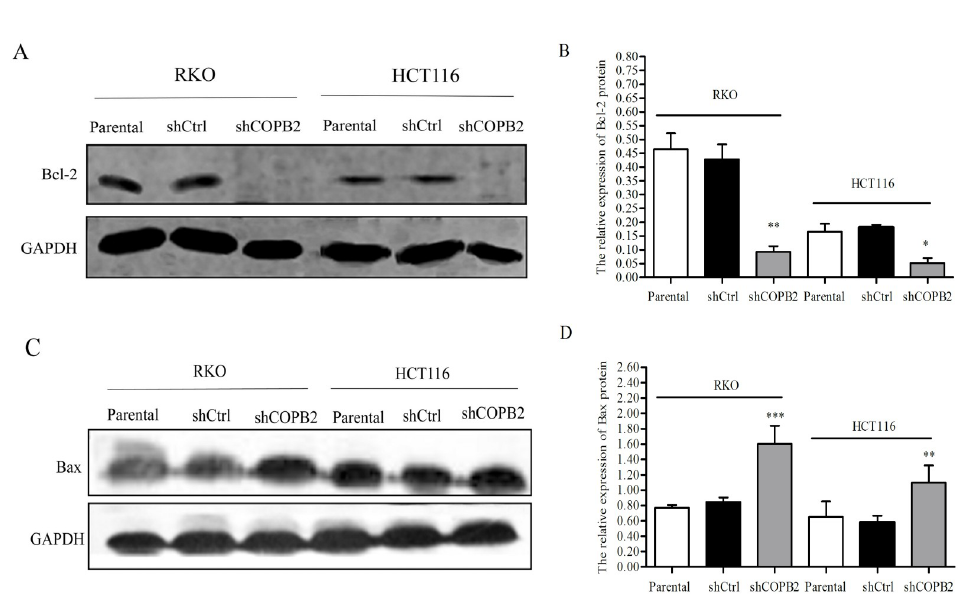
Fig 6. Western blot analysis of apoptosis-related proteins expression in RKO and HCT116 cells. ( A-B ) Following knockdown of COPB2, the protein expression level of Bcl-2 was reduced in RKO and HCT116 cells, ��� P < 0.001 or � P < 0.05 compared with shCtrl and parental cells groups. ( C-D ) In contrast, the expression level of Bax was increased in RKO and HCT116 cells. ��� P < 0.001 or �� P < 0.01 compared with shCtrl and parental cells groups.